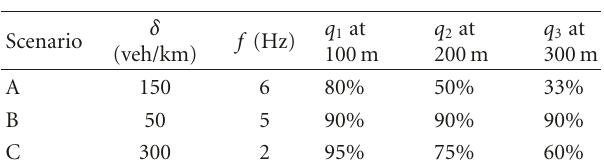
Table 4: Scenario